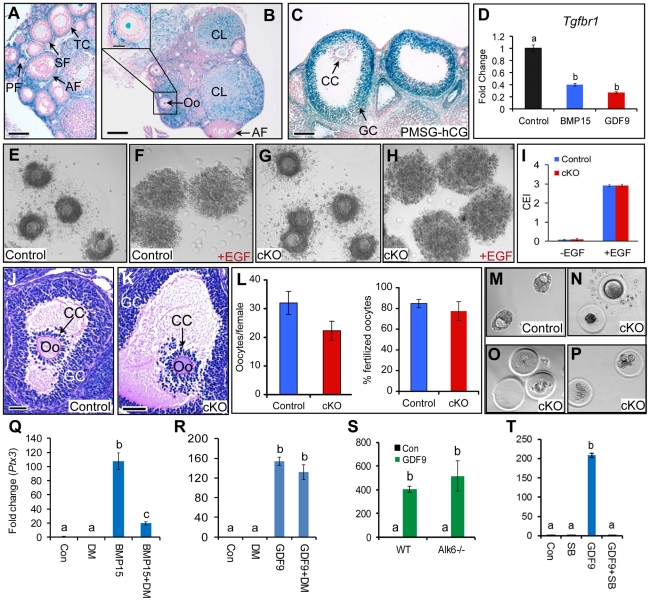
Cellular distribution and functional characterization of TGFBR1 in mouse ovary.(A to C) β-gal staining of ovaries from immature [(A; untreated) and (C; PMSG-hCG treated)] and adult (B) Tgfbr1
+/bgal mice. (D) Suppression of Tgfbr1 mRNA in mouse granulosa cells by recombinant BMP15 or GDF9 after 5 h treatment (n = 3). (E to H) Expansion of COCs from control and Tgfbr1 cKO mice in vitro in the absence (E and G) or presence (F and H) of EGF (10 ng/ml). (I) Cumulus expansion index (CEI) of the in vitro cultured COCs from control (n = 4) and Tgfbr1 cKO (n = 5) mice. (J and K) Preovulatory follicles from Tgfbr1 cKO mice demonstrating cumulus expansion. PF, primary follicle; SF, secondary follicle; AF, antral follicle; Oo, oocyte; TC, thecal cell; GC, granulosa cell; CC, cumulus cell; CL, corpus luteum; COC, cumulus-oocyte complex. Scale bars = 50 µm (J and K); 100 µm (A and C); and 200 µm (B). (L) Ovulation and oocyte fertilization potential of Tgfbr1 cKO mice (n = 8–10). (M to P) Blastocysts or degenerated oocytes/embryos recovered from control (M) and Tgfbr1 cKO mice (N to P). (Q to T) Identification of receptor preference for GDF9 signaling in mouse granulosa cells using small molecule inhibitors and Alk6
−/− granulosa cells. Dorsomorphin (DM; 4 µM) was preincubated with granulosa cells for 1 h before BMP15 (100 ng/ml) or GDF9 (15 ng/ml) was added. DM markedly reduced Ptx3 induction by BMP15 (Q), while a similar effect was not observed on GDF9-induced Ptx3 mRNA expression (R). Induction of Ptx3 mRNA by GDF9 (100 ng/ml) was not attenuated in Alk6−/− granulosa cells (S). However, SB-505124 (SB; 1 µM) suppressed GDF9-induced Ptx3 mRNA expression (T). Con, control. n = 3 for each group. Relative mRNA levels of Tgfbr1 and Ptx3 were normalized to Gapdh. Data are presented as mean ± SEM. Bars without a common letter are significantly different at P<0.05.